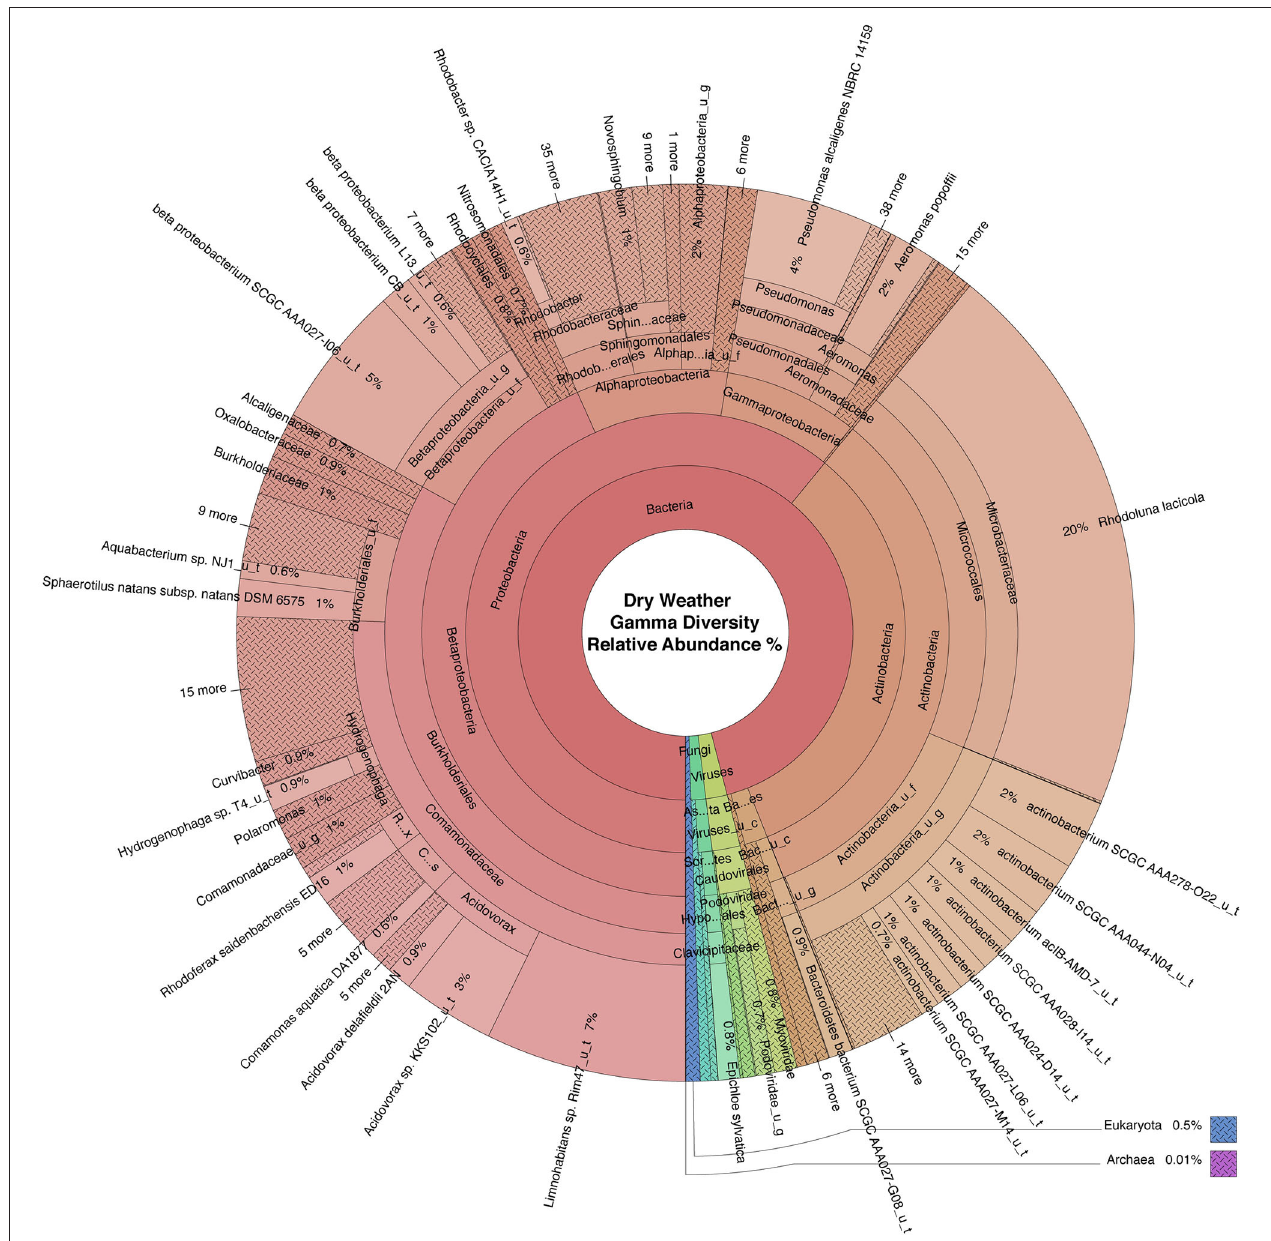
FIGURE 4 | Krona plot of normalized dry weather water microbiome. Species composition percentages are displayed as average number of organism specific k-mers detected, normalized to represent the proportion of organism specific k-mers observed relative to total microbial species diversity detected across samples obtained from all four locations during the dry weather sampling event. Red, bacteria; blue, protozoa; teal, fungi; purple, archaea; green,